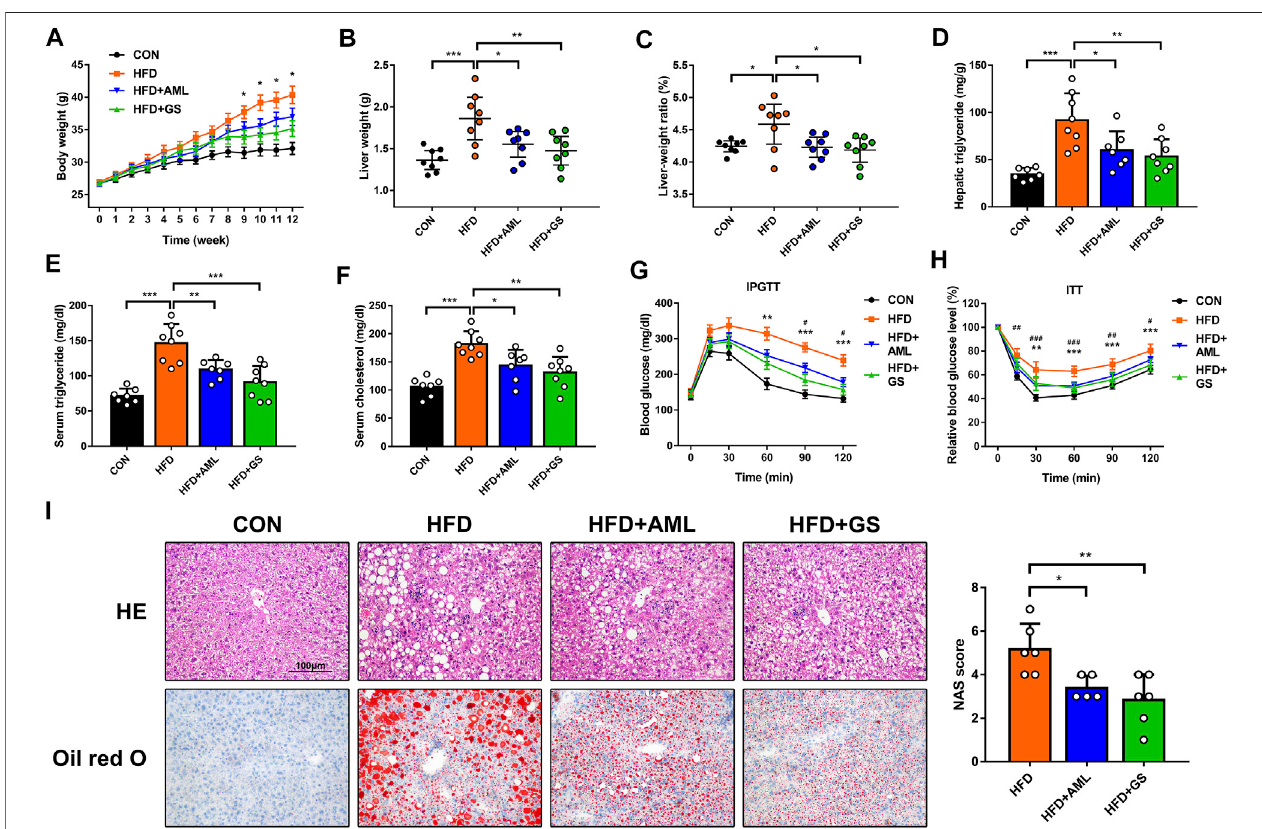
FIGURE 2 | GS improved in fl ammation and insulin resistance in high-fat-fed mice. (A) The body weights were recorded weekly, n (cid:1) 8. *p < 0.05 between the HFD groupandtheGSgroup. (B,C) Theliverweightsandliver-to-bodyweightratioweremeasuredandcalculatedattheendofthisexperiment, n (cid:1) 8. (D – F) Thehepaticand serum concentrations of triglyceride and cholesterol were detected by ELISA, n (cid:1) 6 – 8. (G, H) IPGTT and ITT, n (cid:1) 7 – 8. **p < 0.01, ***p < 0.001 between the HFD group andtheGSgroup. # p < 0.05, ## p < 0.01, ### p < 0.001 betweentheHFDgroupandtheAMLgroup. (I) HEandoilredOstaining,whiletheNASscorewascomputed by steatosis, intralobular in fl ammation and hepatocyte ballooning to assess disease severity, n (cid:1) 6. Results are presented as means ± SD. *p < 0.05, **p < 0.01, ***p < 0.001